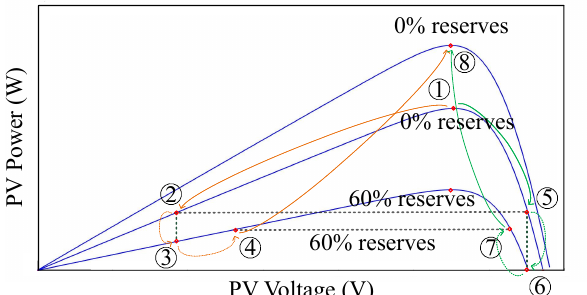
Figure 6. Variations of operating point when irradiance level changes.